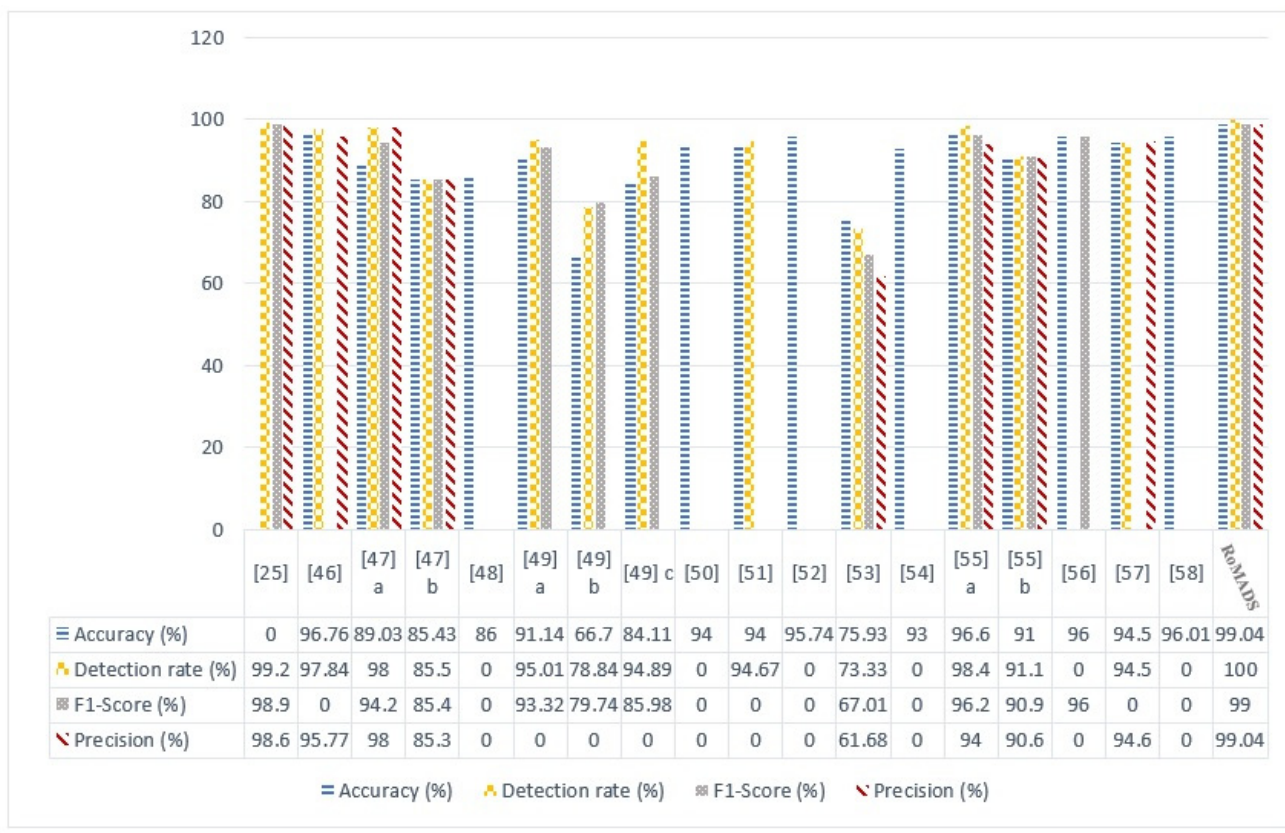
Figure 25. Comparison between RoMADS model results and the previous paper’s results based on Accuracy, Recall & Detection rate, F1-Score, Precision.